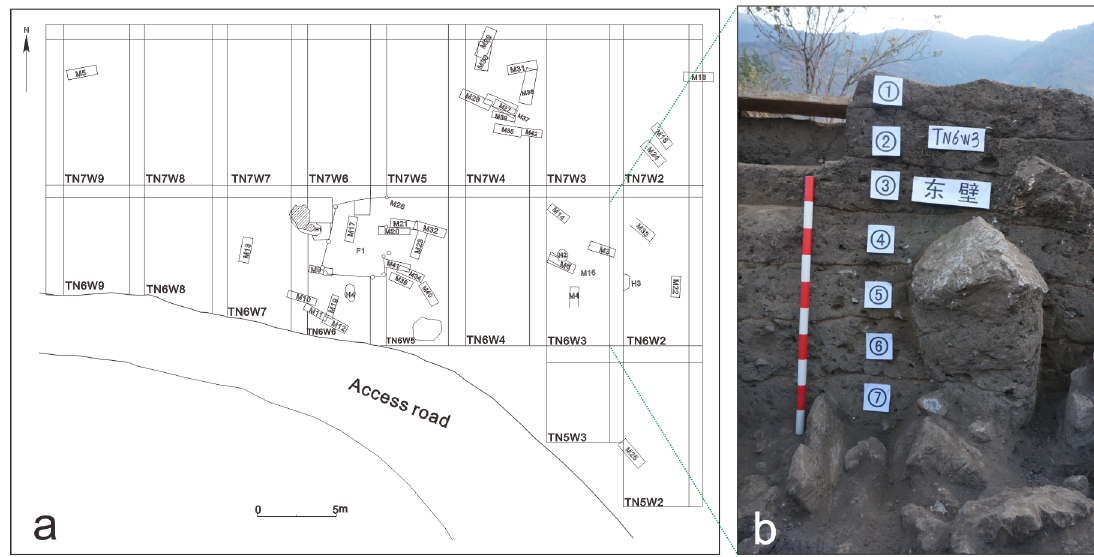
Fig 2. Plan map of northern Shilinggang and stratigraphic column from unit TN6W3. a) Plan map of the northernpart of Shilinggang. Rectangularexcavation units are labeledstarting with the letter T. Features includeburials (labeledwith the letter “M”), pits (labeledwith the letter “H”), and buildingfoundations(labeledwith the letter “F”). The features shown in Fig 2a are modifiedfrom Li et al. [28]. b) Photographof stratigraphicprofile in unit TN6W3 (center right of plan map in Fig 2a). Circles aroundnumbersindicate stratigraphic